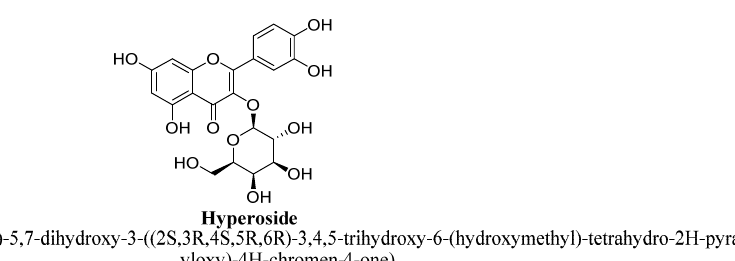
Figure 18. Isoquercitrin.